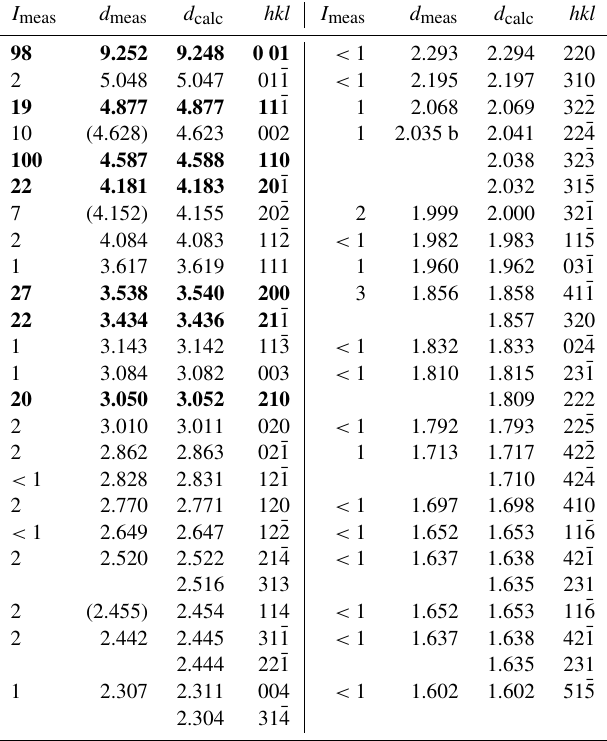
Table 2. X-ray powder diffraction data ( d in Å) for freitalite. Values in brackets are shoulders. Seven strongest lines are highlighted in